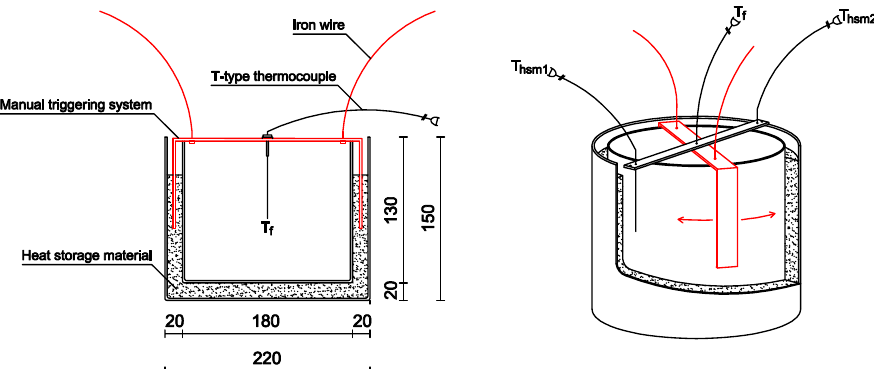
Figure 4. Thermal energy storage. The device used for the mechanical agitation of xylitol is drawn in